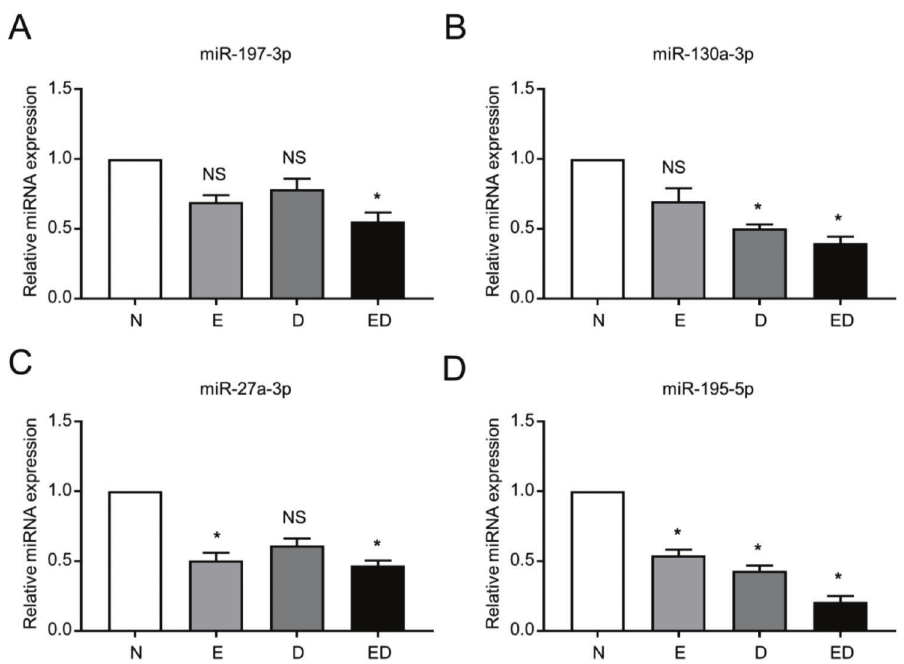
Figure 3 - Plasma miR-195-5p expression was downregulated in the patients. A-D Validation of plasma levels of significantly downregulated miRNAs, including miR-197-5p ( A ), miR-130a-5p ( B ), miR-27a-5p ( C ), and miR-195-5p ( D ) by miRNA chip ( A ) and qRT-PCR. U6 was used as an internal control. All data are shown as the mean ± SEM (n=5), * p o 0.05; NS, not